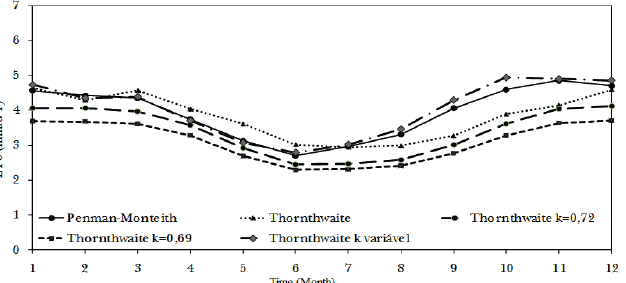
Fig. 2 Evapotranspiration calculated by different methods in Tapacurá basin.